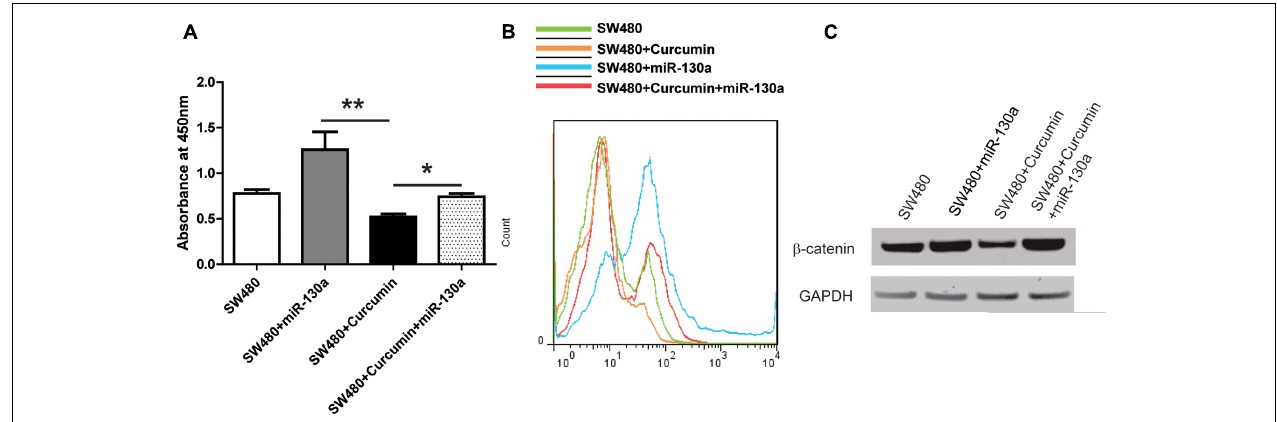
FIGURE 5 | Curcumin inhibited Wnt pathway via miR-130a. (A) CCK-8 kit was used to evaluate the viability of each group of the cells as indicated. Data were represented as mean ± SD; n = 3 independent experiments. ∗ p < 0.05, ∗∗ p > 0.05. (B) Cell proliferation was detected by BrdU incorporation assay and n = 3 independent experiments and this panel presented one of these repeats. (C) Western blot analysis of the protein expression of β -catenin and GAPDH in SW480 cells. n = 3 independent experiments and this panel presented one of these repeats.